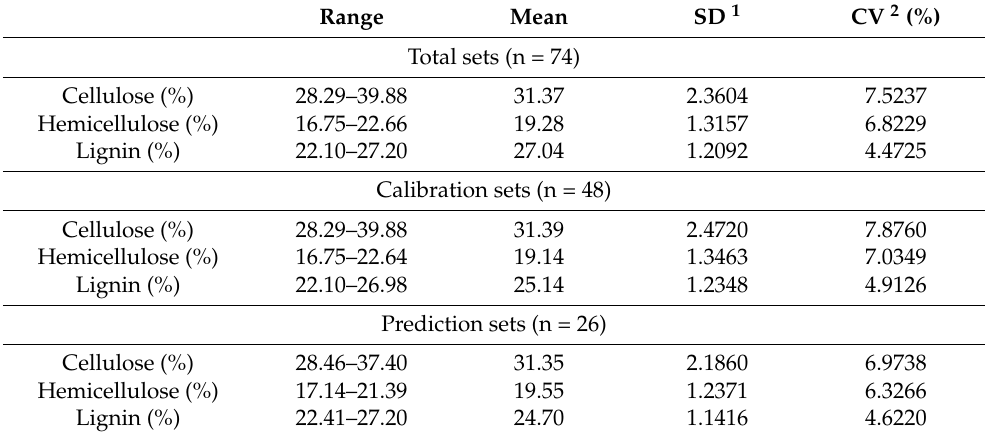
Table 1. Reference measurement results of samples in the calibration and prediction sets (lignocellu- lose in Sargassum horneri ).